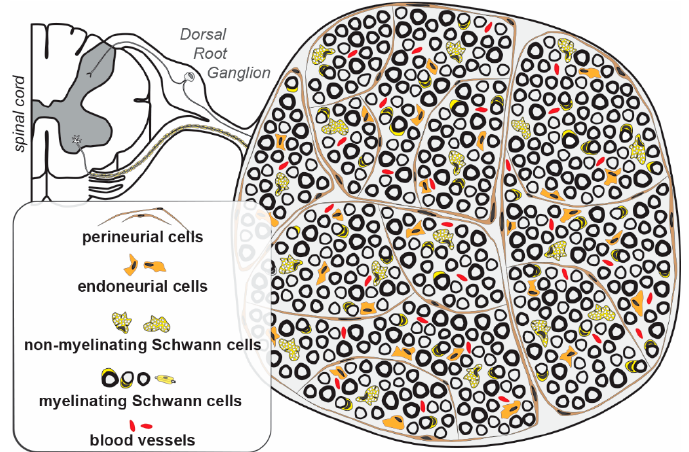
Figure 1. Peripheral nerve cellular structure. Sensory neurons emanating from the dorsal part of the spinal cord with their somata in dorsal root ganglia project their axons towards the spinal cord on the one hand and their peripheral endpoints on the other. Some of these sensory axons are myelinated by Schwann cells, and others are ensheathed by non-myelinating Schwann cells in specific structures called “Remak bundles”. Motor axons emanating from the ventral roots of the spinal cord are wrapped by myelinating Schwann cells. Perineurial cells surround multiple axons and Schwann cells to delineate fascicles. They provide mechanical and structural integrity to these fascicles. Endoneurial cells are dispersed inside the fascicles. They provide major components of the extracellular matrix, perform immune-surveillance, and are implicated in remyelination. The vasculature is composed of endothelial cells surrounded by pericytes that provide the nerve-blood barrier.